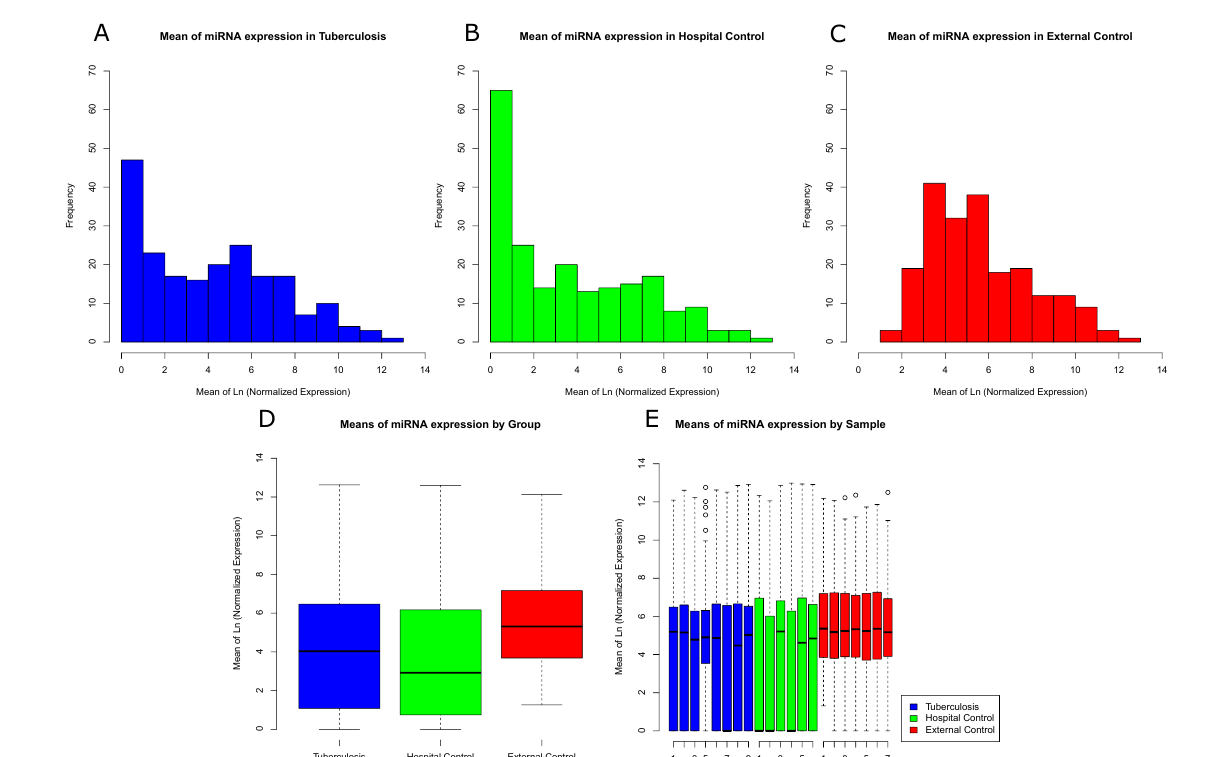
Figure 1. Frequency distribution of miRNA reads among sample groups: ( A ) log-normalized miRNA mean frequency distribution in Tuberculosis samples; ( B ) log-normalized miRNA mean frequency distribution in Hospital Control samples; ( C ) log-normalized miRNA mean frequency distribution in External Control samples; ( D ) log-normalized miRNA mean expression by groups; and ( E ) log-normalized miRNA mean expression by sample. One sample from the Tuberculosis patients group was filtered and removed due to low sequence